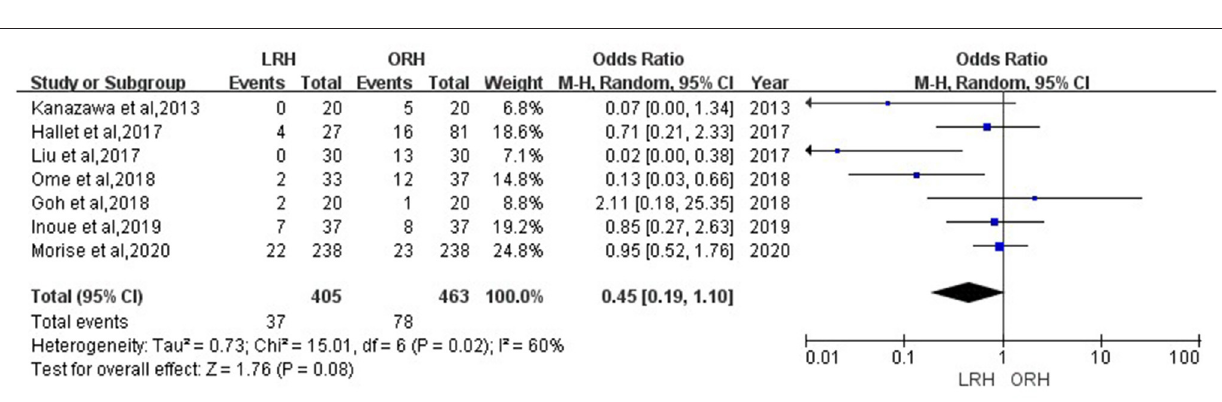
FIGURE 9 | Forest plots comparing major postoperative complications rate between LRH group and ORH group.